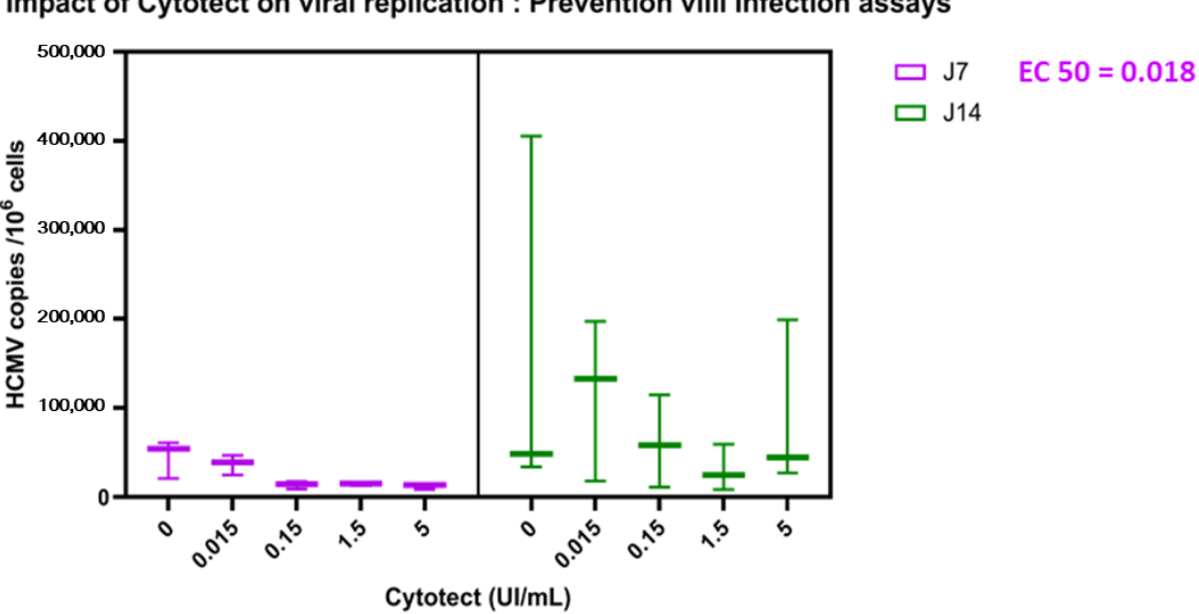
Figure 5. Prevention of villi infection assays. Virus and Cytotect CP ® were added at the time of explant infection. The viral loads in the villi were measured at 7 and 14 days post-infection by comparison with the infected and non-treated villi (positive control “0”). The results were compiled from three placentae. The statistical analyses were carried out using GraphPad Prism with a two-way ANOVA (GraphPad Software, San Diego, CA, USA). The whiskers are extended to the extreme data points.